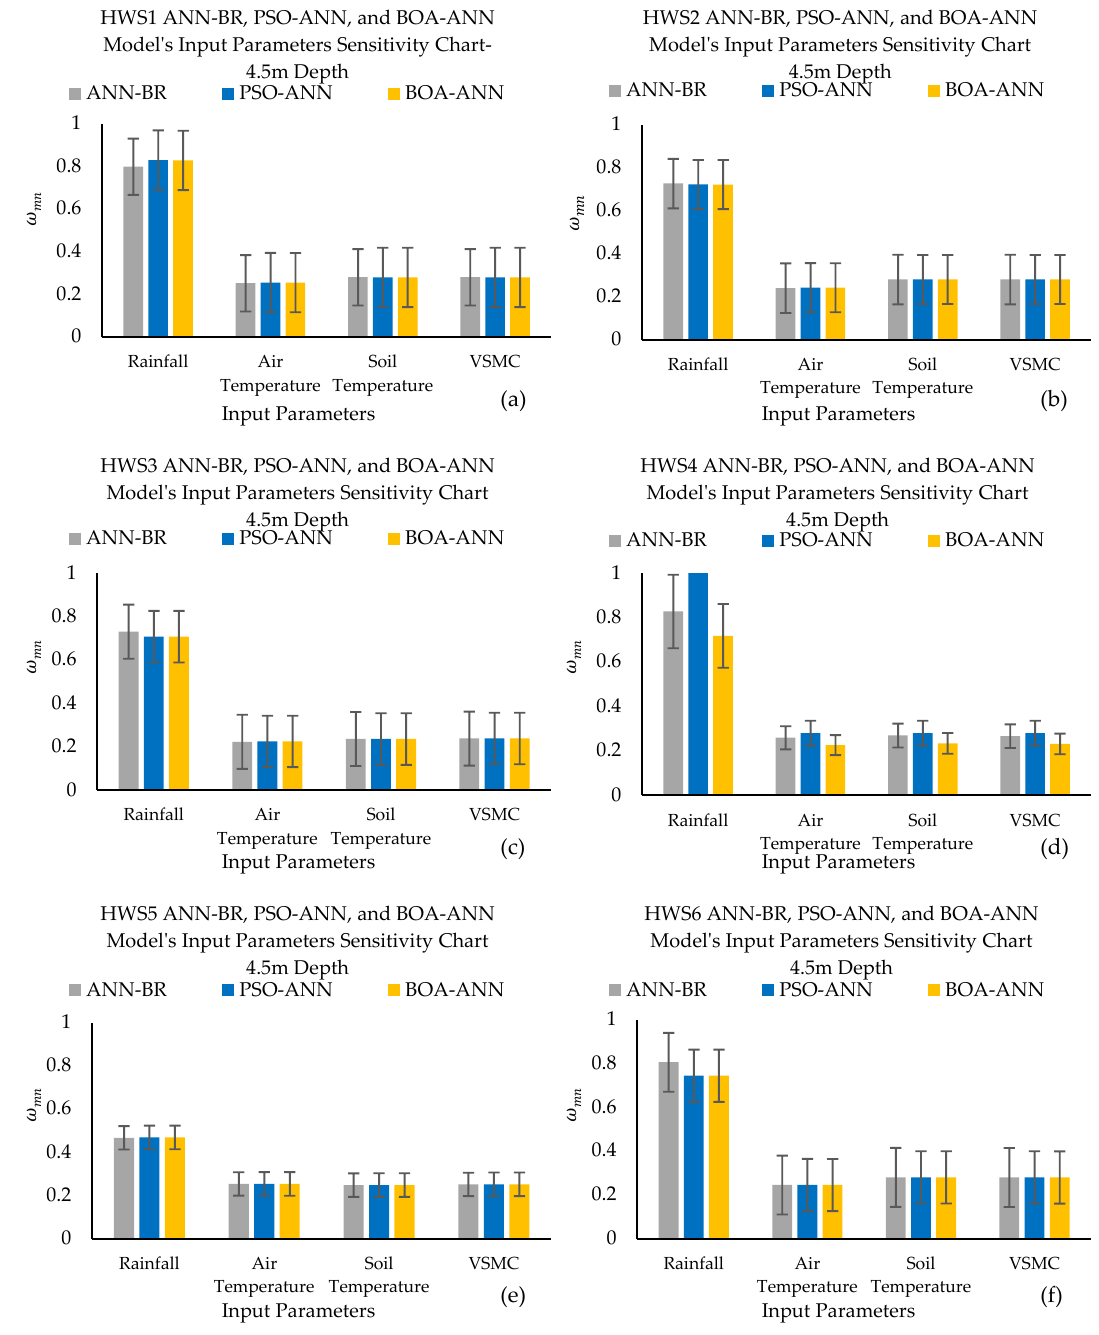
Figure A8. The sensitivity factor of input parameters on the predicted output for the ANN-BR, PSO-ANN, and BOA-ANN at 4.5 m depth ( a ) HWS 1 ( b ) HWS 2 ( c ) HWS 3 (d) HWS 4 ( e ) HWS 5 ( f ) HWS 6.